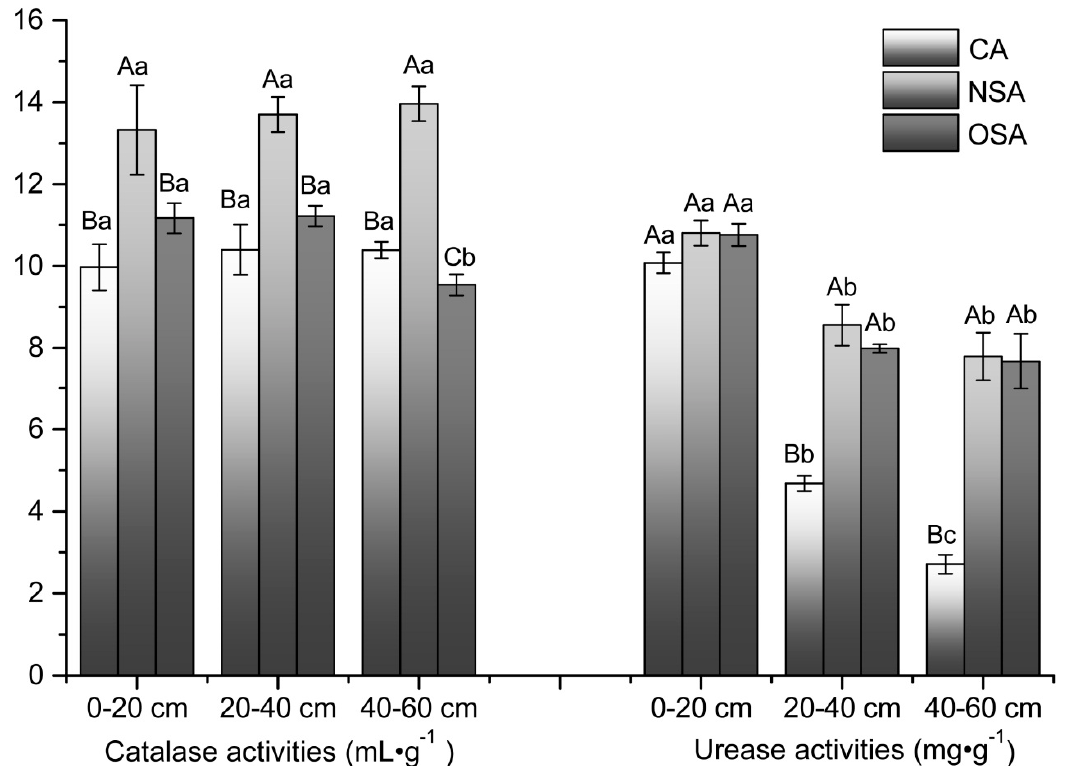
Figure 4. Catalase activities and urease activities in soil layers of different sample plots. Note: lowercase letters represent the significance of differences between soil layers within a sample plot; where the letters are different, there is a significant difference ( p < 0.05). Uppercase letters represent the significance of differences between sample plots for the same soil layer; where the letters are different, there is a significant difference ( p < 0.05).